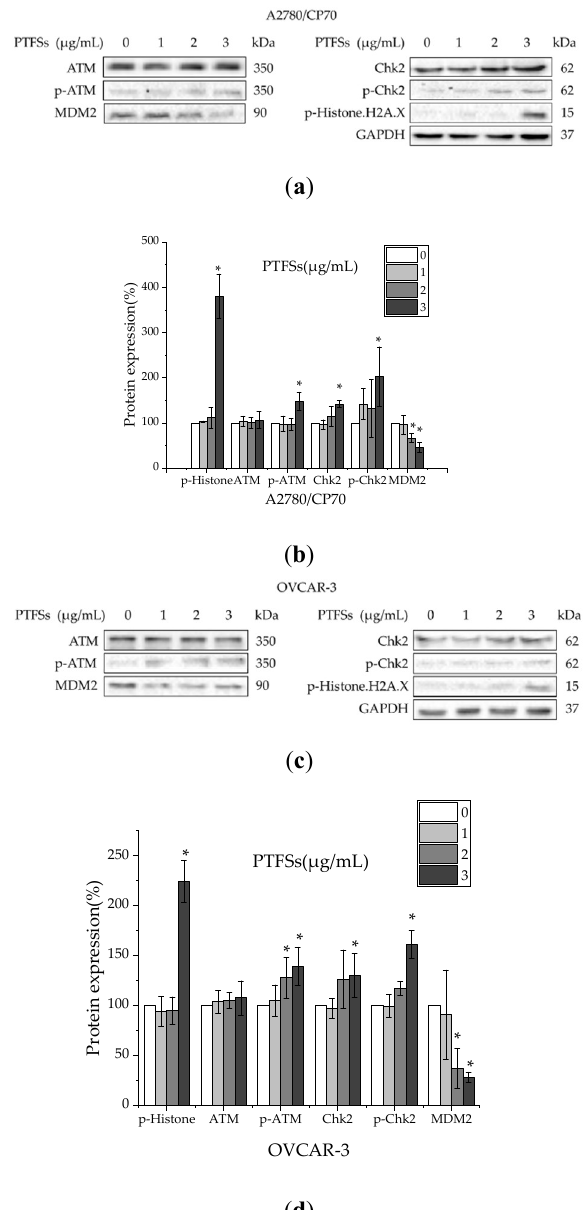
Figure 7. The changes in DNA damage-related proteins in ovarian cancer cells treated with PTFSs. ( a , c ) A2780 / CP70 and OVCAR-3 cells were treated with PTFSs (0, 1, 2, 3 µ g / mL) for 24 h. p-Histone H2A.X, ATM, p-ATM, Chk2, p-Chk2, MDM2 and GAPDH protein expression were detected by Western blotting. ( b , d ) The changes in the protein levels induced by PTFSs are expressed as quantification histograms with error bars in A2780 / CP70 and OVCAR-3 cells. GAPDH was utilized for an endogenous reference to standardize protein levels. Results are expressed as mean ± SEM from three independent experiments. * p < 0.05 versus control. Cells treated with culture medium containing 0.01% DMSO was used as the control.